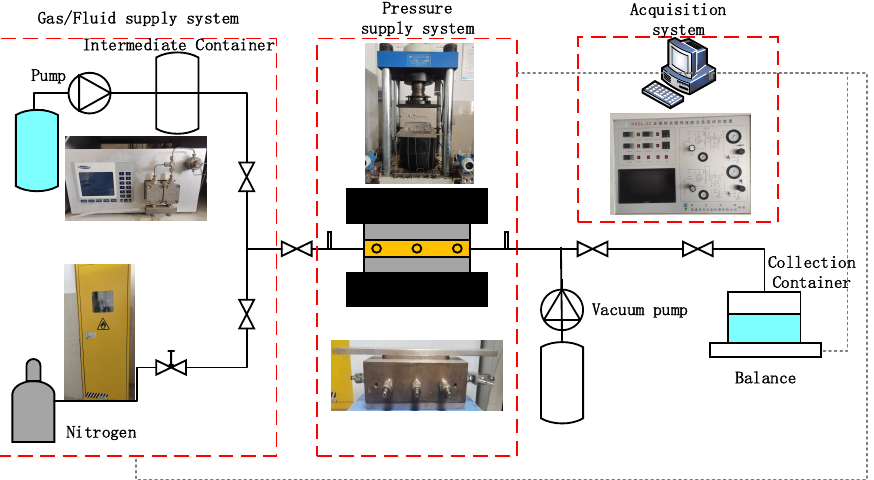
Figure 1. Flow conductivity damage test procedure.